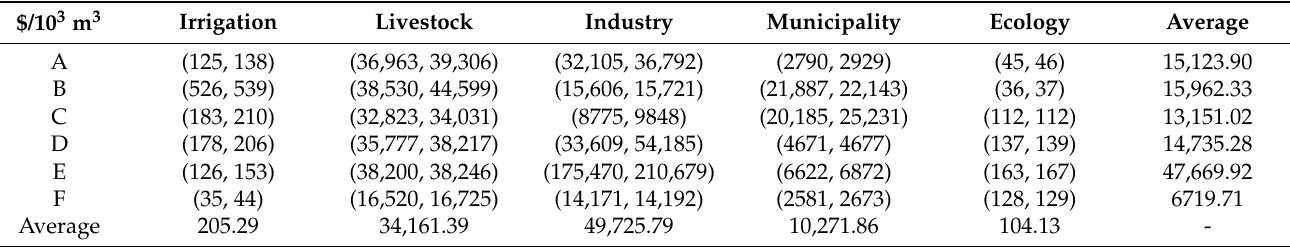
Table 7. The economic benefit coefficient.